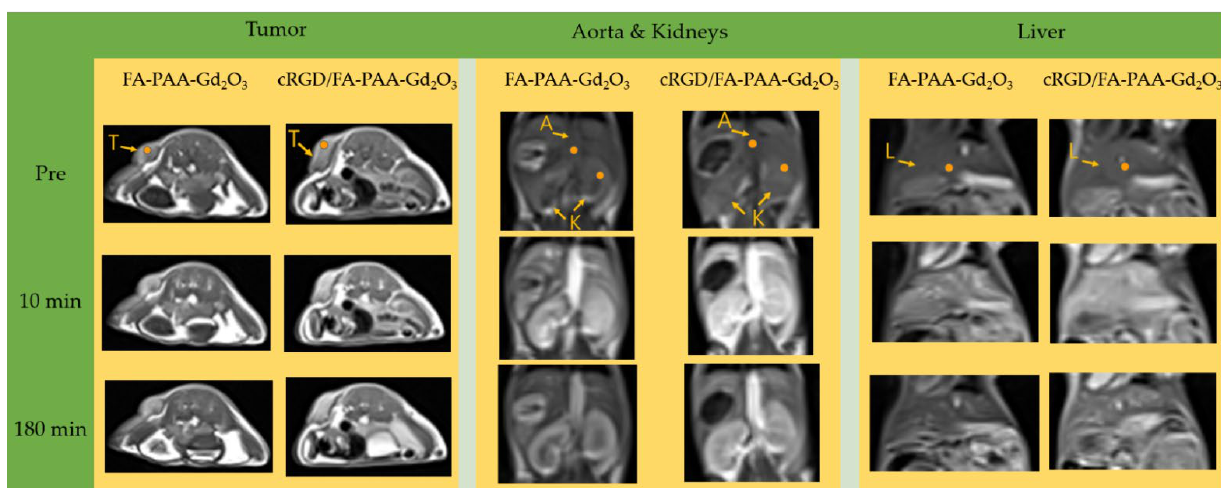
Figure 8. T 1 MR images at a 3.0 T MR field as a function of time before (labeled as “Pre”) and after intravenous injection of aqueous FA-PAA-Gd 2 O 3 and cRGD/FA-PAA-Gd 2 O 3 nanoparticle suspension samples into mice tails. “T” denotes the tumor, “A” denotes the aorta, “K” denotes the kidneys, and “L” denotes the liver. The regions of interest (ROIs) are labeled with small dots.